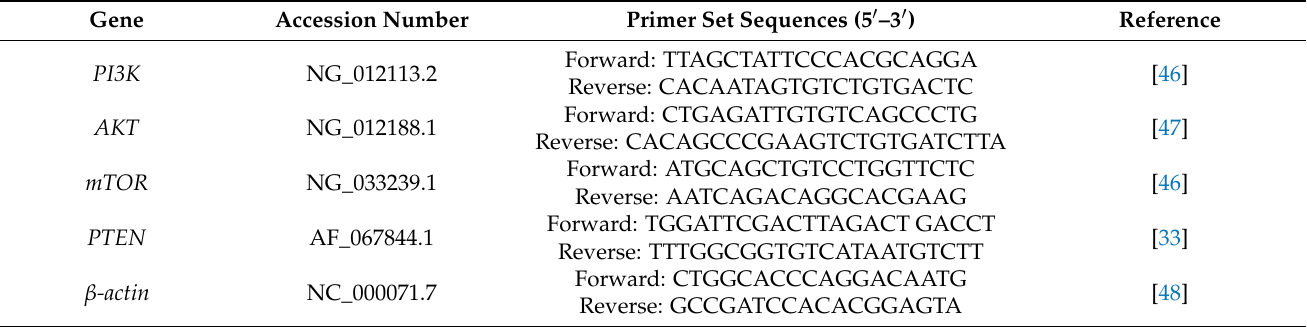
Table 3. The sequences of the primer set for RT-qPCR